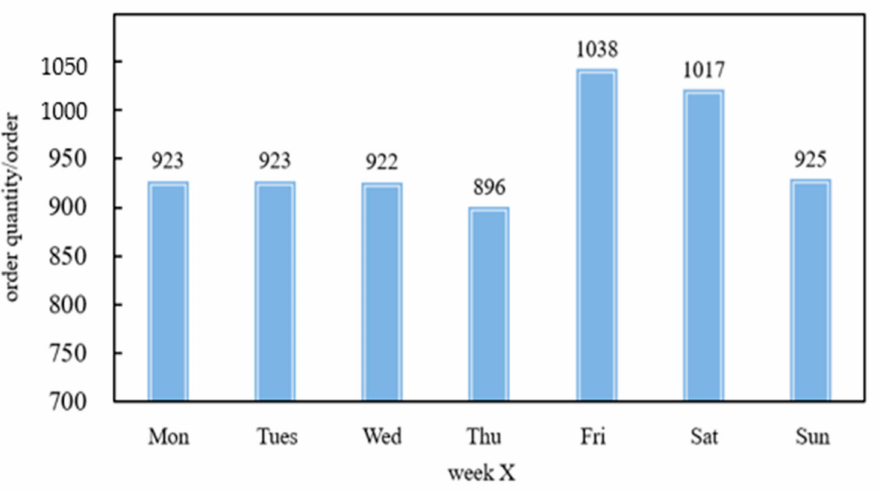
Figure 2. User’s week travel characteristics.